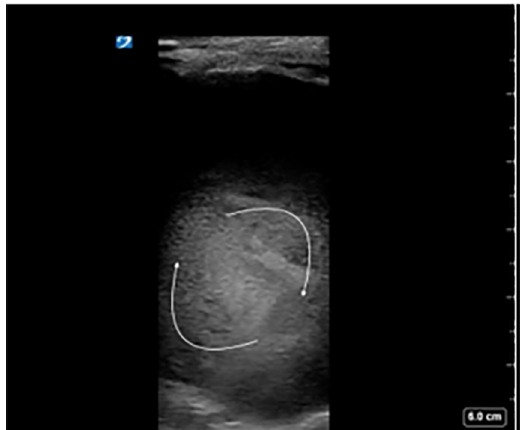
Image 6a. B-mode imaging of the distal medial upper arm revealed a heterogenous circular collection with demonstration of swirling of contents.